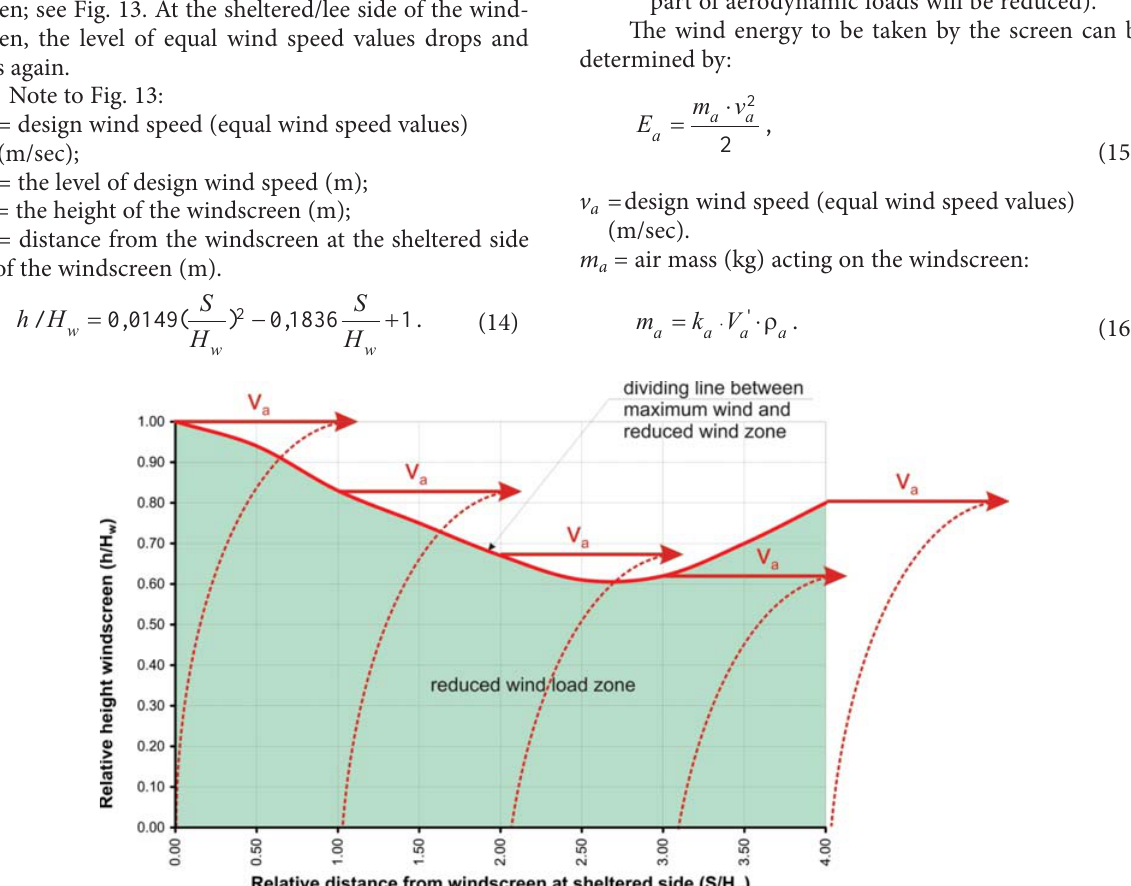
Fig. 13. Windscreen infl uence on the sheltered/lee side of the windscreen